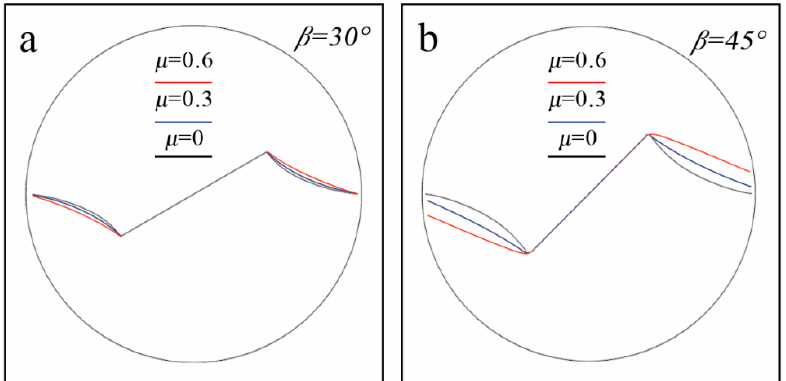
Figure 10. The propagation trajectories simulated by the MFEM under different friction coefficients for α = 0.5.